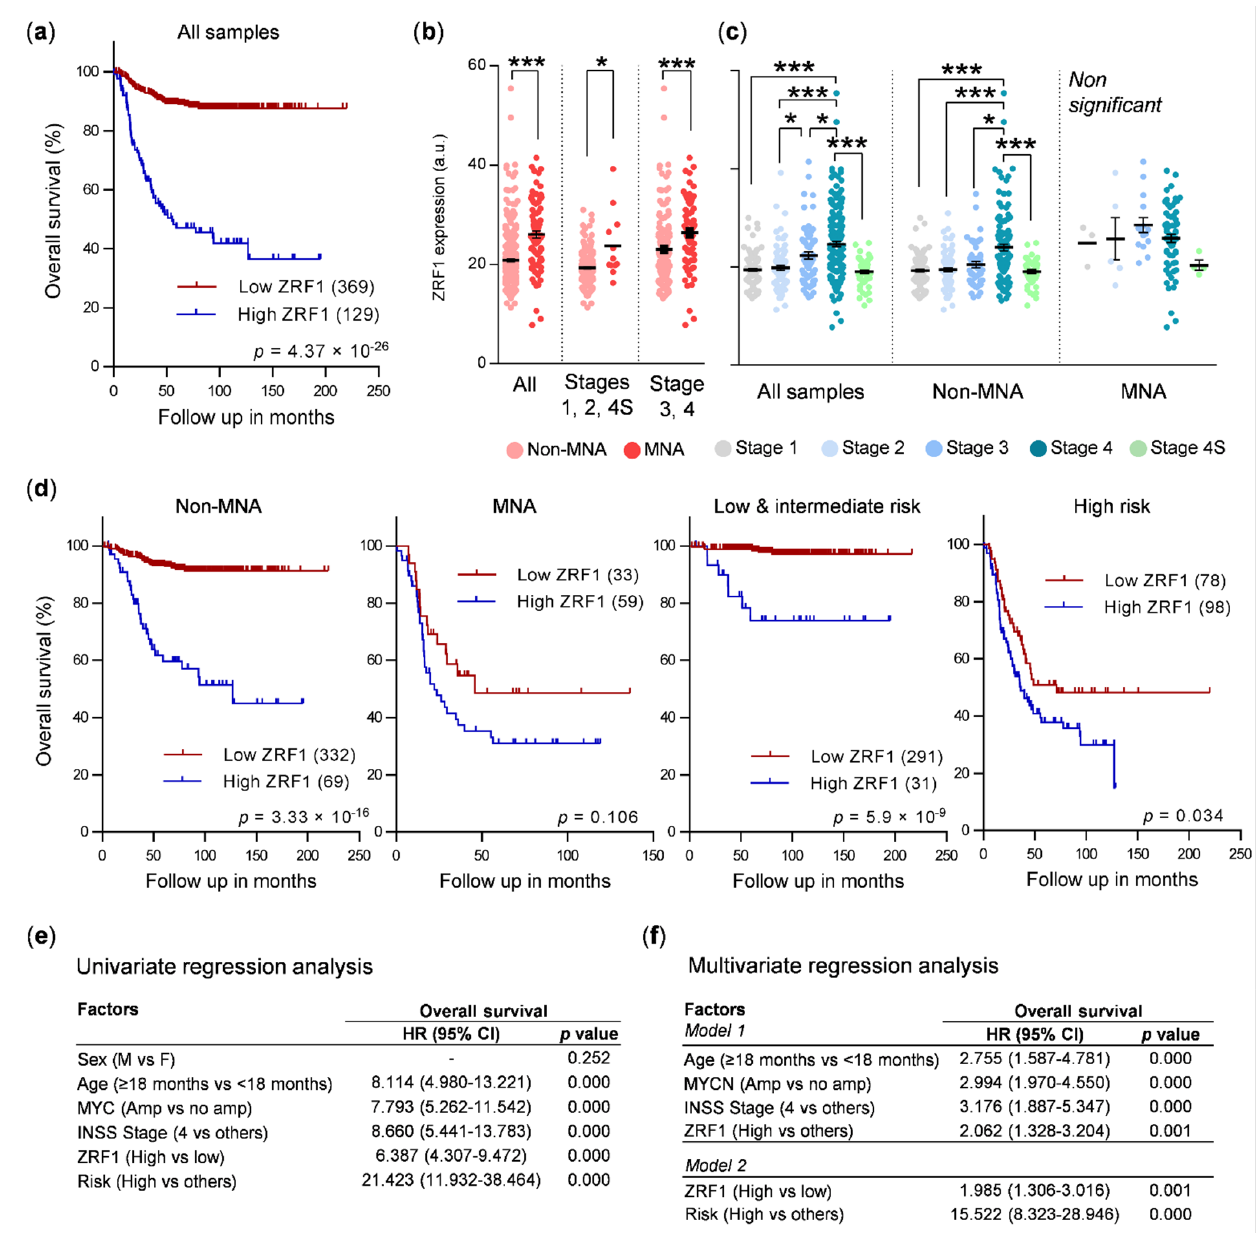
Figure 1. ZRF1 is an independent prognostic factor in neuroblastoma. ( a ) Kaplan–Meier survival plot of a cohort of 498 patients (GSE62564) split into high and low ZRF1 mRNA expression, based on the Youden index. ( b ) ZRF1 mRNA levels in MYCN-amplified tumors (MNA, dark red) vs non-MYCN amplified tumors (non-MNA, light red), according to the indicated disease stages. ( c ) ZRF1 mRNA levels according to disease stage in the whole cohort (left) or considering patients with non-MNA (middle) or with MNA tumors (right). ( d ) Kaplan–Meier survival plots comparing samples with high and low ZRF1 levels in the indicated groups of patients. ( e ) Cox univariate regression analysis of overall survival with different clinic-pathological features. ( f ) Cox multivariate regression analysis of overall survival results confirm ZRF1 mRNA levels as an independent prognostic marker in neuroblastoma. * means p < 0.05; ** means p < 0.01; *** means p < 0.001. HR: hazard ratio.